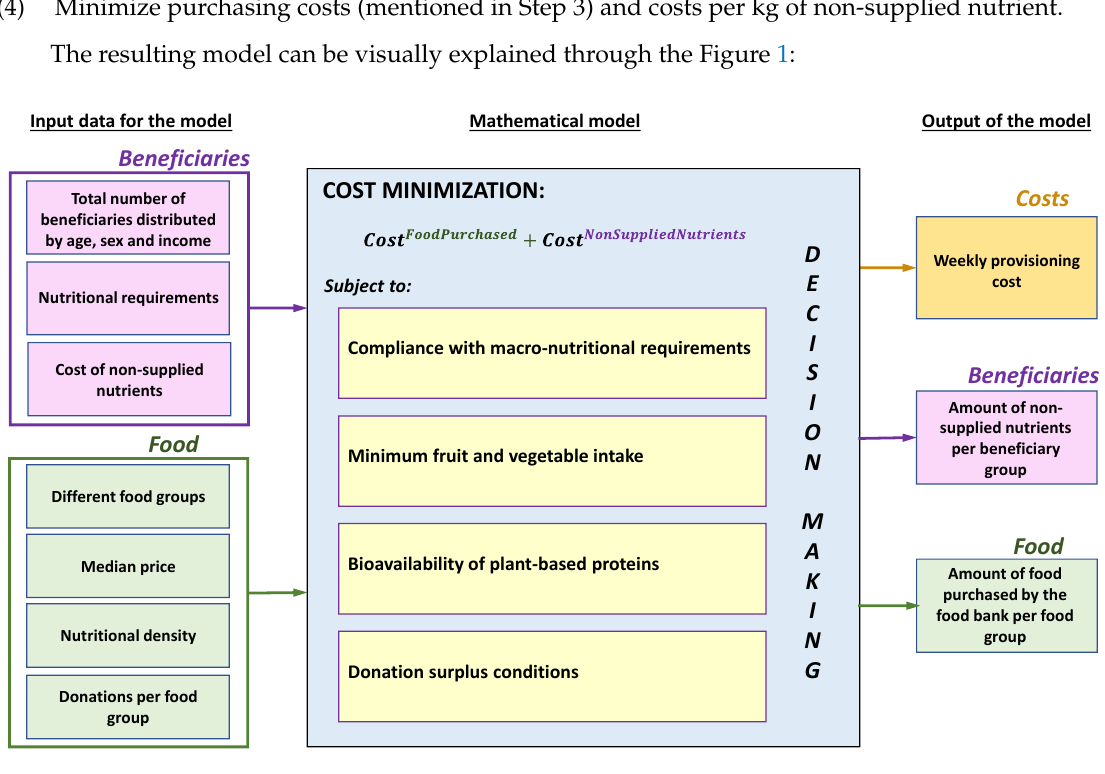
Figure 1. Conceptual schema of the model.